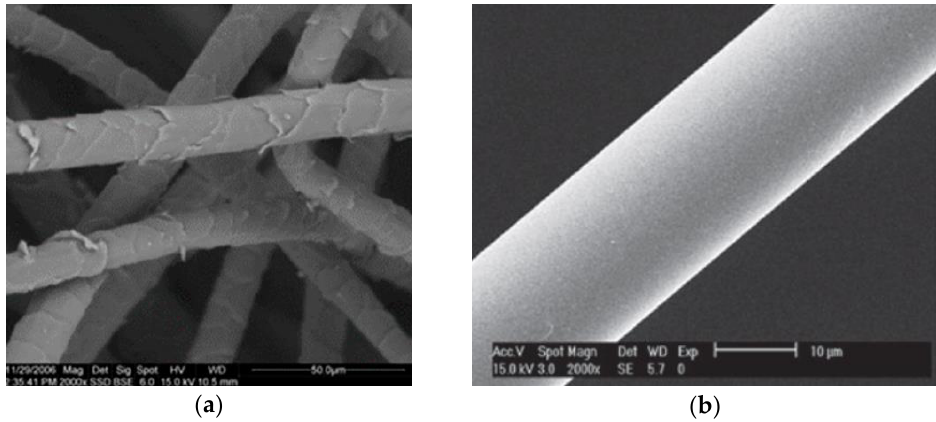
Figure 2. SEM image of ( a ) sheep’s wool fibre showing its surface scales [30] (CC BY 4.0, 2020, Sustainability), and ( b ) man-made synthetic smooth glass fibre [38] (BY-NC-ND 3.0, 2017, E-